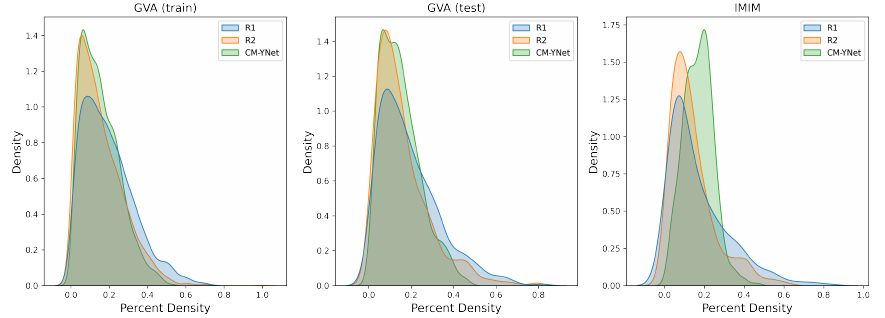
Figure 9. Density plots for the percent density (PD) annotated by the two experts (R1 and R2) and the mask output of the CM-YNet